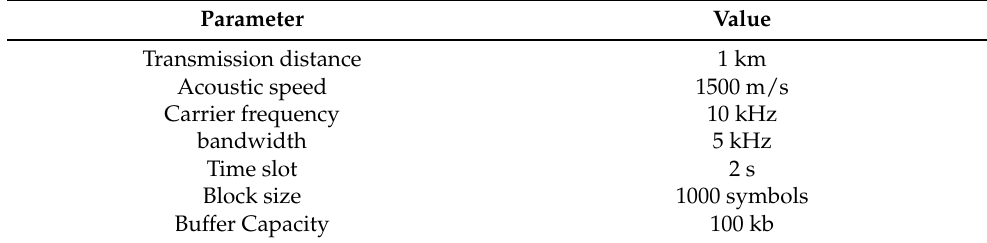
Table 1. Simulation